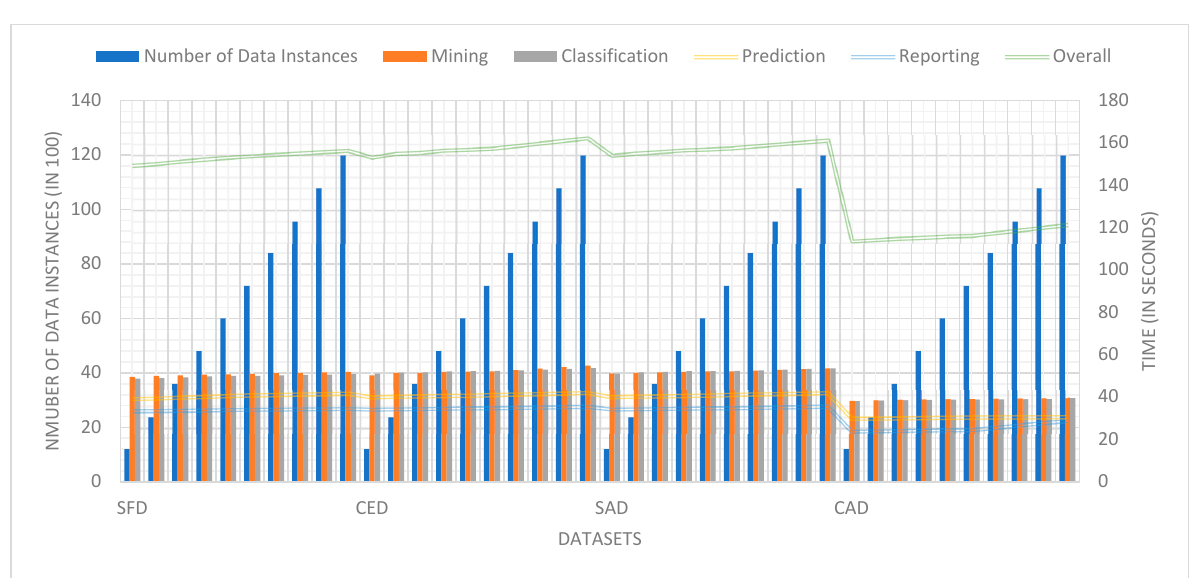
Figure 6. The delay efficiency of the proposed framework.